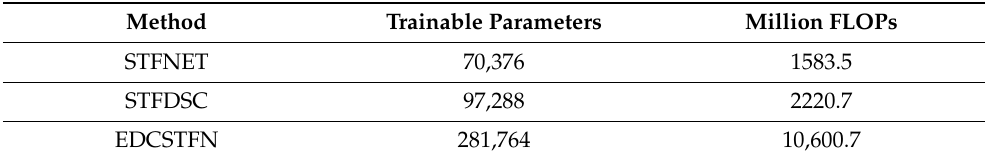
Table 4. The number of trainable parameters and forward propagated floating-point operations of the three CNN-based STF